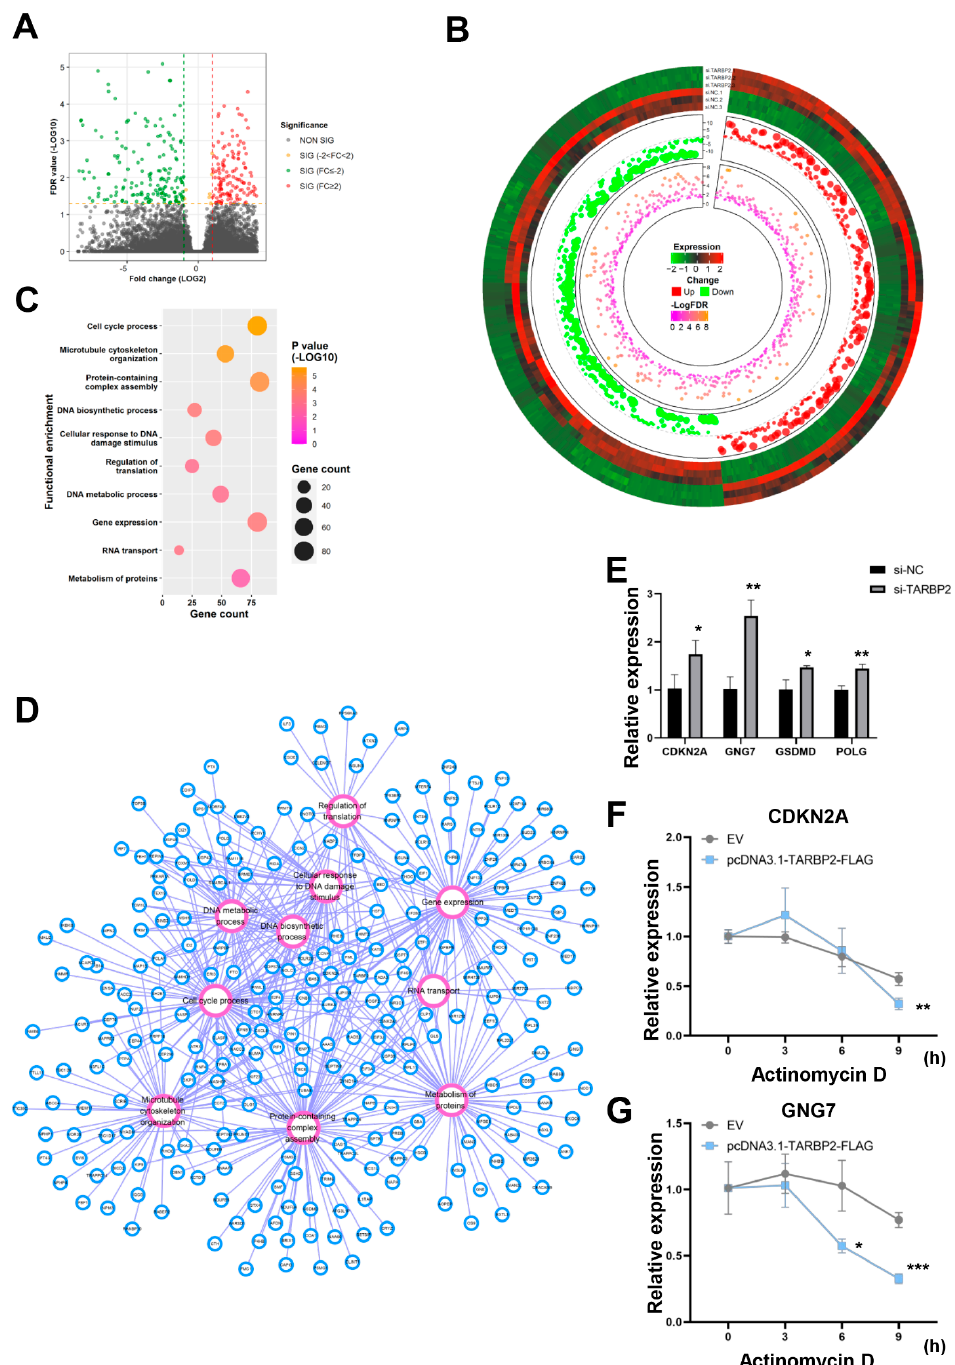
Figure 5. The potential downstream target mRNA of TARBP2 in GC cells. ( A , B ) Volcano plot and circular heatmap showing the differentially expressed transcripts between the si-TARBP2- and si- NC-transfected HGC-27 cells based on RNA-sequencing data (fold change > 2.0 and FDR < 0.05). ( C ) The KEGG pathways and GO biological processes enriched in the differentially expressed genes. ( D ) Network diagram of functional enrichment: purple circles represent function, blue circles repre- sent gene, and lines represent relationships between gene and function. ( E ) The mRNA expression levels of candidate tumor suppressors (based on the enriched pathways) in si-TARBP2-transfected HGC-27 cells (n = 3). ( F , G ) RNA stability assay results showing the degradation rates of CDKN2A and GNG7 in HGC-27 cells transfected with pcDNA3.1-TARBP2-FLAG or an empty vector (EV) (n = 3). * p < 0.05, ** p < 0.01, and *** p <